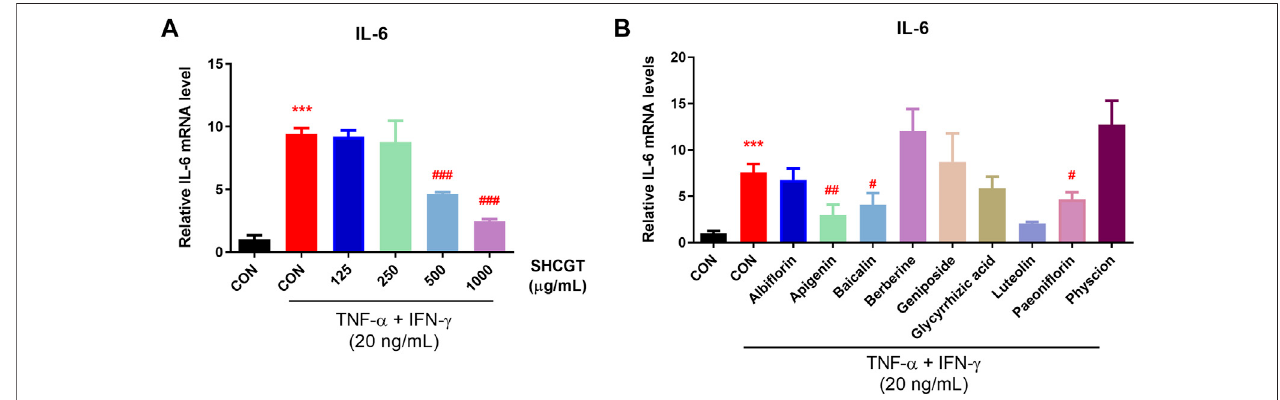
FIGURE 9 | SHCGT dose-dependently affected the atopic dermatitis and bioactive compounds in SHCGT had an inhibitory effect in TNF- α /IFN- γ -treated HaCaT cells. (A) SHCGT regulated the expression of IL-6 mRNA expression in TNF- α /IFN- γ -treated HaCaT cells in dose-dependent manners. (B) The compounds in SHCGT showed inhibitory effect on IL-6 mRNA expression in TNF- α /IFN- γ -treated HaCaT cells. HaCaT cells were pretreated with SHCGT or compounds at predetermined concentrations (SHCGT, 125 – 1,000 μ g/ml; albi fl orin, 100 μ M; baicalin, 50 μ M; geniposide, 100 μ M; glycyrrhizic acid, 100 μ M; paeoni fl orin, 100 μ M; apigenin, 25 μ M; luteolin, 25 μ M; berberine hydrochloride, 50 μ M; and physcion, 100 μ M) for 6 h and then stimulated with TNF- α (20 ng/ml) and IFN- γ (20 ng/ml) for an additional 18 h. *** p < 0.001 vs. CON; # p < 0.05, ## p < 0.01, ### p < 0.001 vs. TNF- α /IFN- γ -treated CON (CON + TNF- α /IFN- γ ). CON, control; TNF- α , tumor necrosis factor-alpha; IFN- γ , interferon-gamma; IL-6, interleukin-6; SHCGT, Sihocheonggan-Tang